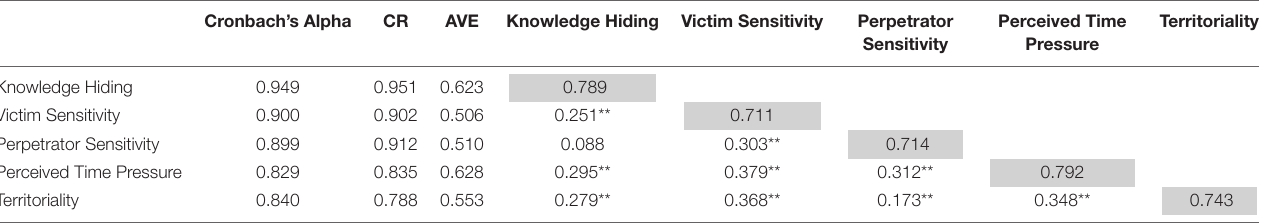
TABLE 2 | Reliability, validity, and correlation coefficients of latent